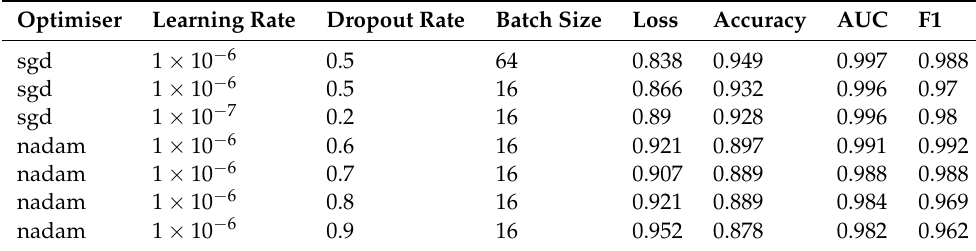
Table 2. WeathercAIm validation classification metrics for different training parameters. Optimiser Learning